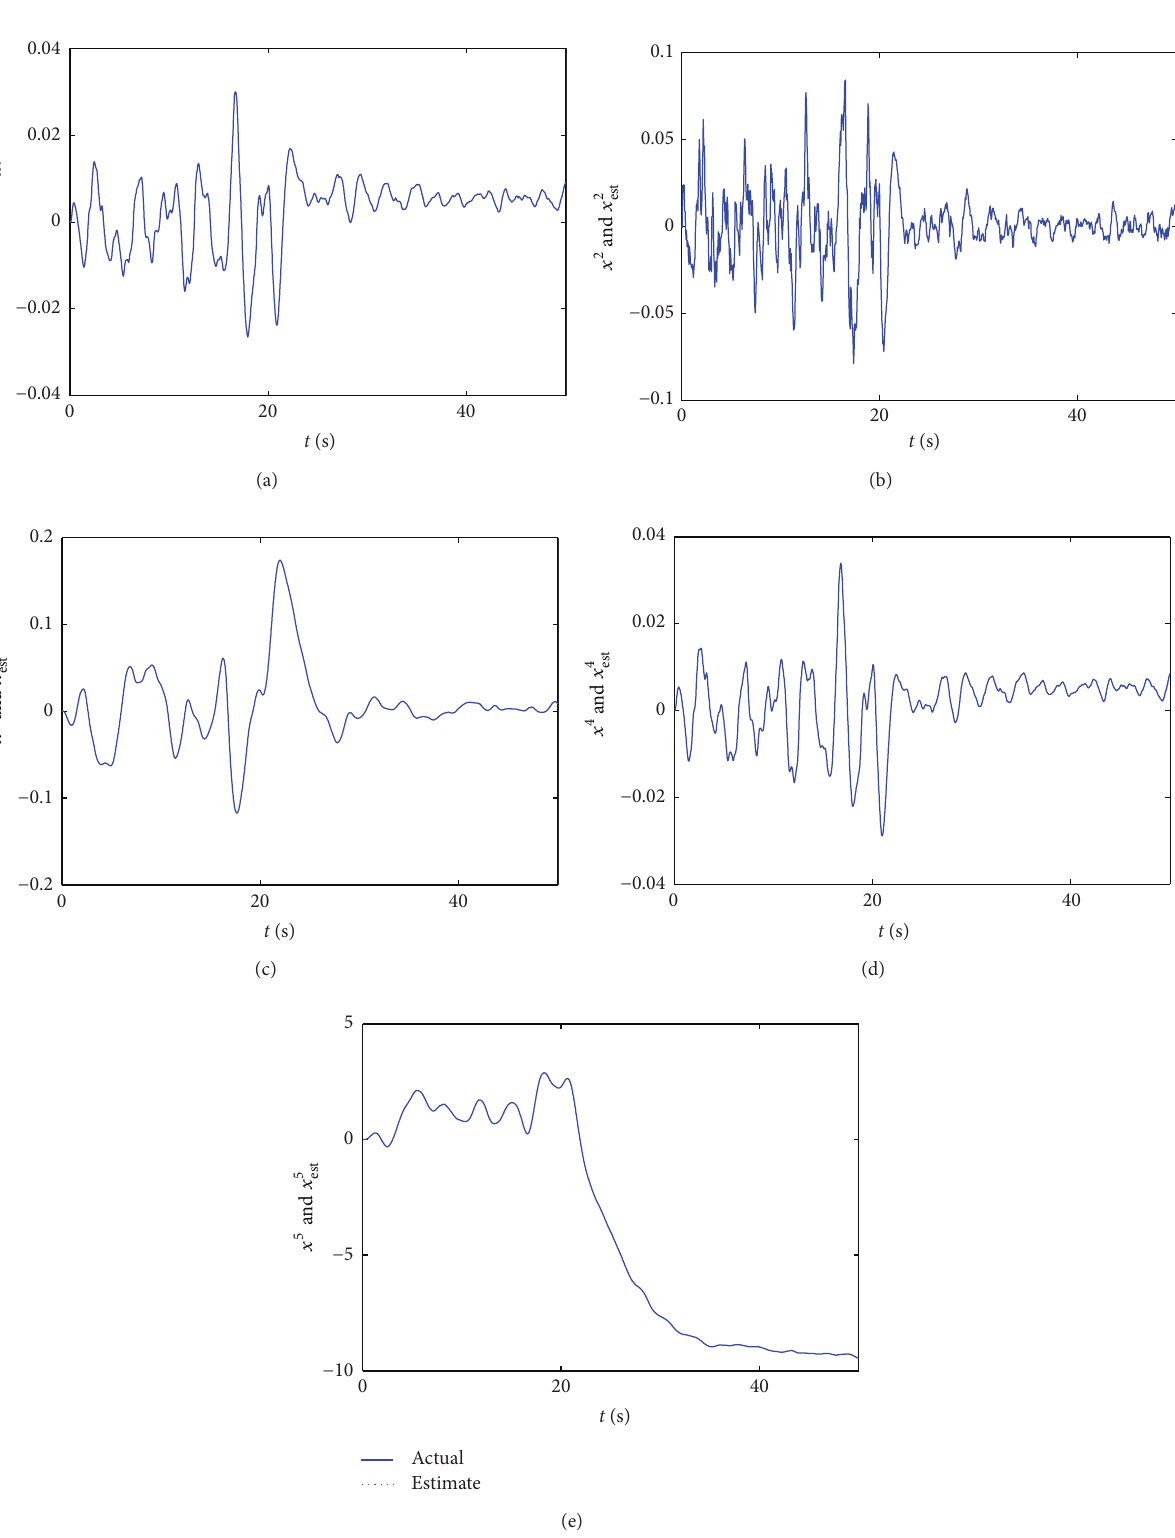
Figure 3: Actual state variables and estimations when a stuck fault in stabilizer occurred at 20 seconds. Since actual and estimated state variables are too close, two curves are seen as one